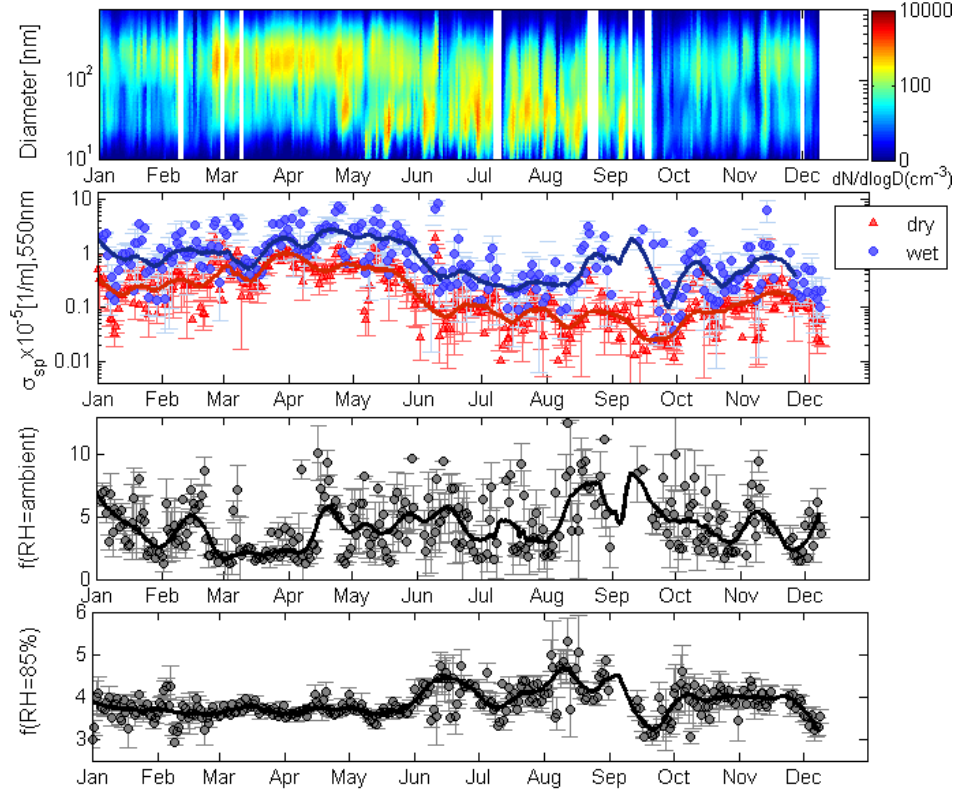
Figure 9. (a) Number size distributions measured at the Zeppelin station for year 2008. (b) The calculated daily mean scattering coefficients for the Dry and Wet cases (see Table 2). (c) The calculated daily mean enhancement factors f (ambient RH) for the Wet case. (d) The four calculated daily mean enhancement factors f (RH = 85%). In all figures the error bars indicate standard deviations. Note that the scale is different in (c) and Fig. 10d.